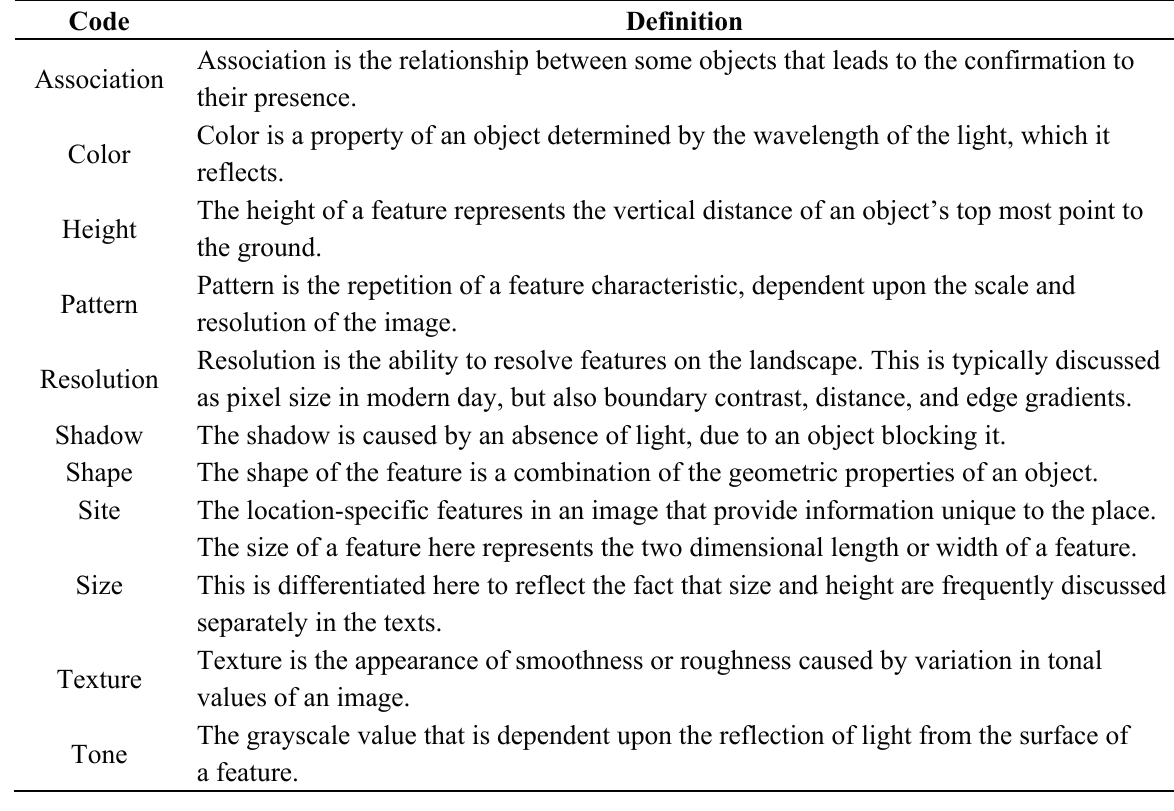
Table 1. Interpretation Elements code set used in this Content